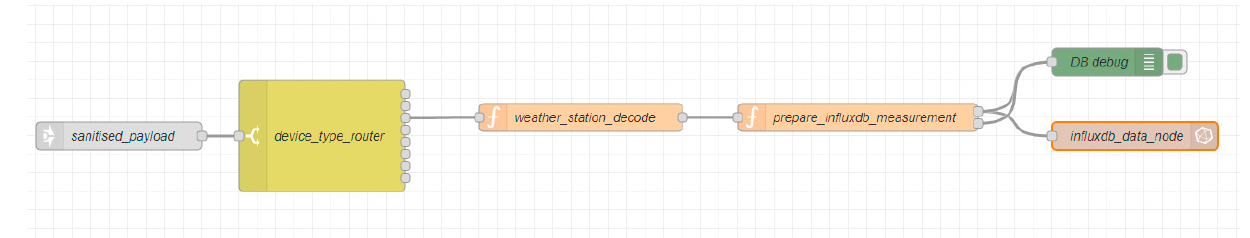
Figure 9. Grafana dashboard of office worksite and weather station sensors.